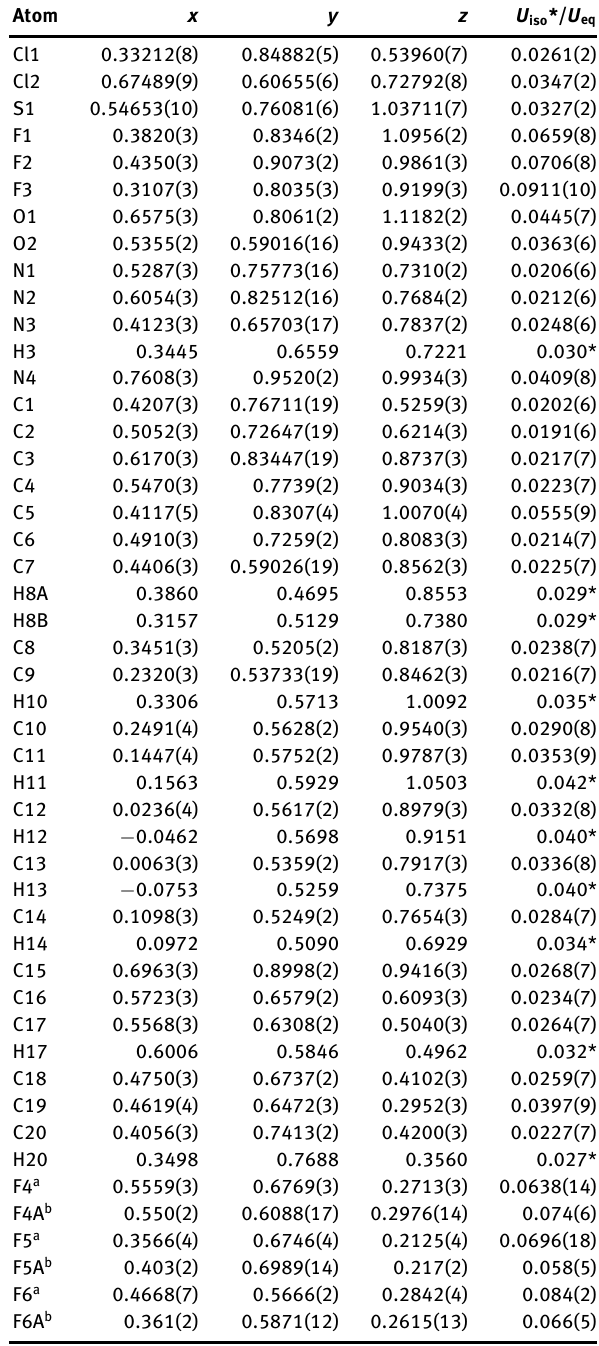
Table 2: Fractional atomic coordinates and isotropic or equivalent isotropic displacement parameters (Å 2